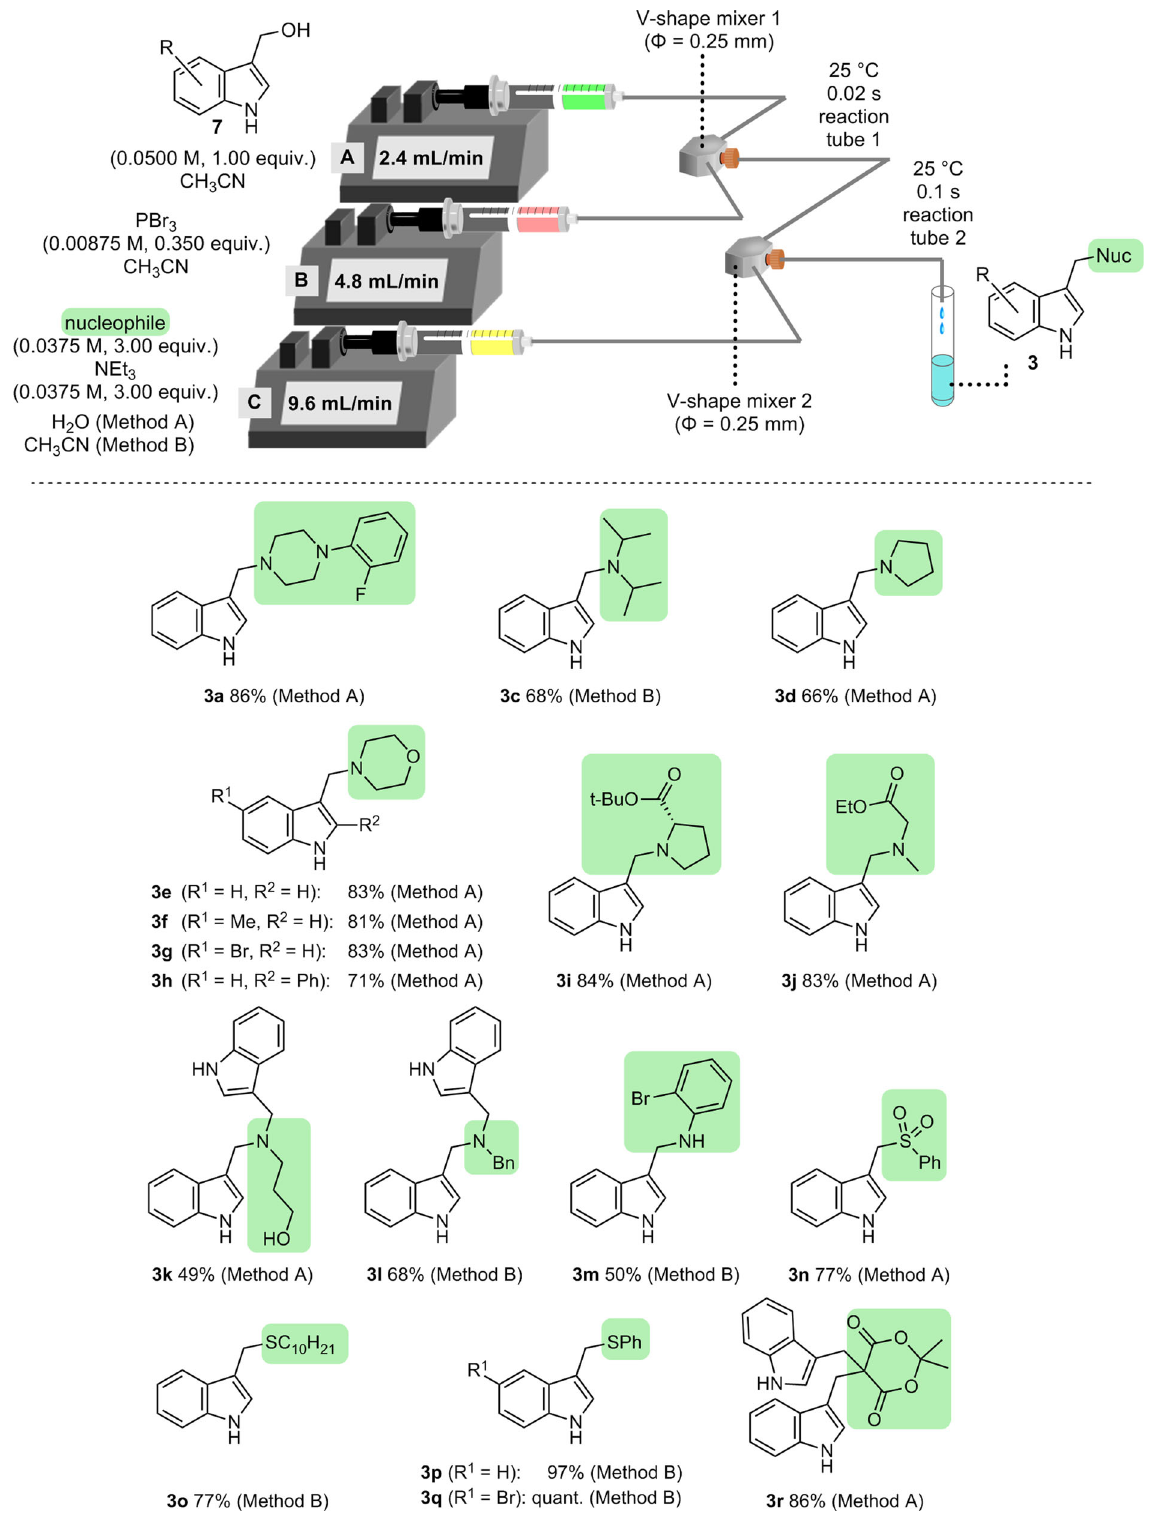
Fig. 4 Scope of the developed micro fl ow nucleophilic substitution. Unless stated otherwise, a solution of substrate 7 (0.0500 M, 1.00 equiv.) in CH 3 CN, a solution of PBr 3 (0.00875 M, 0.350 equiv.) in CH 3 CN, and a solution of nucleophile (0.0375 M, 3.00 equiv.) and NEt 3 (0.0375 M, 3.00 equiv.) were introduced at 25 °C with syringe pumps A, B, and C, respectively. The nucleophile is described in green. Hydrophilic nucleophiles were used in the form of aqueous solutions (Method A), whereas hydrophobic nucleophiles were used in CH 3 CN solutions (Method